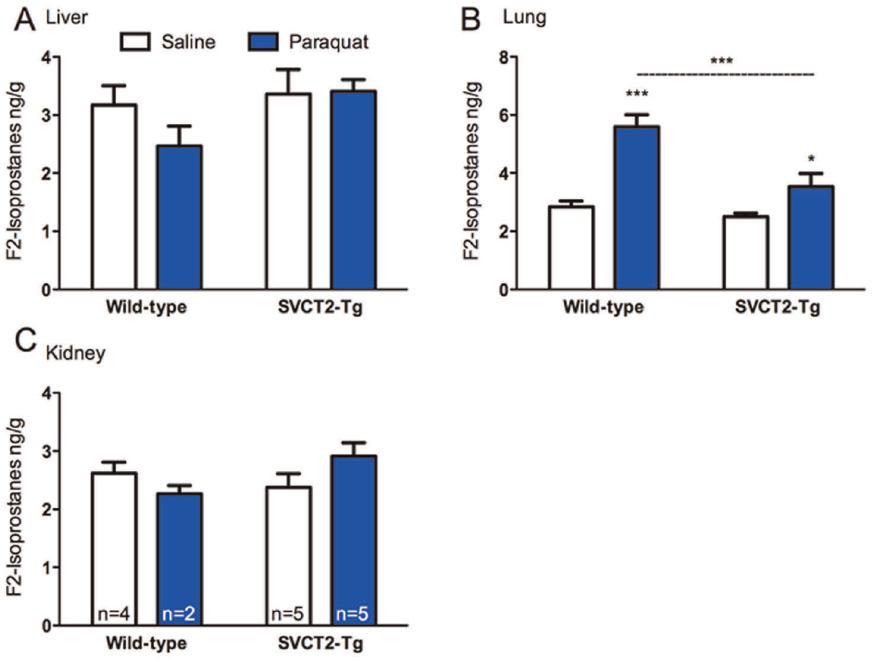
Figure 8. Oxidative stress following treatment with paraquat. F 2 -Isoprostanes were quantified as a marker for oxidative stress following paraquat treatment. F 2 -isoprostanes did not change according to paraquat treatment in (A) liver, or (C) kidney but were significantly elevated in (B) lung. Oxidative damage in lung was attenuated in SVCT2-Tg mice. *, *** p , 0.05, 0.001 different from saline-treated control or as marked. Data shown are mean + S.E.M for wild-type and SVCT2-Tg mice treated with saline (white bars) and paraquat (blue bars). N=5 mice per group, or as